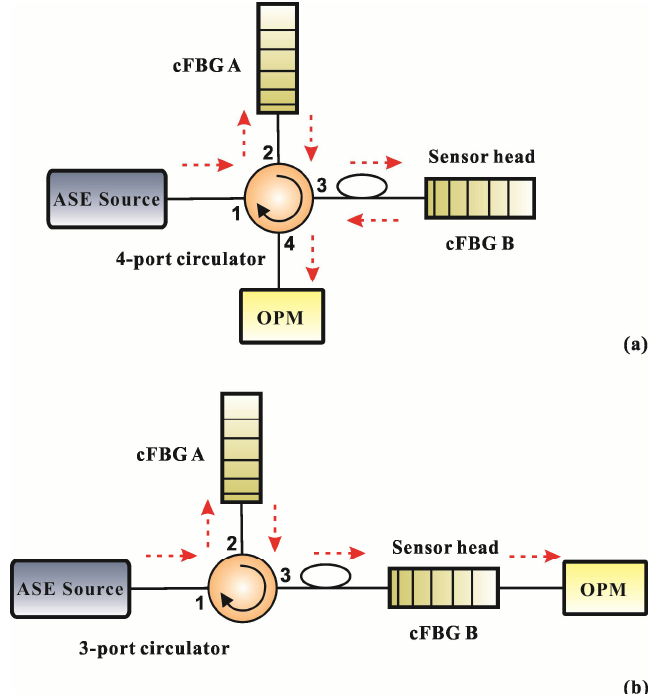
Figure 1. Configuration of an overlap spectrum fiber Bragg gratings (FBG) sensor based on light